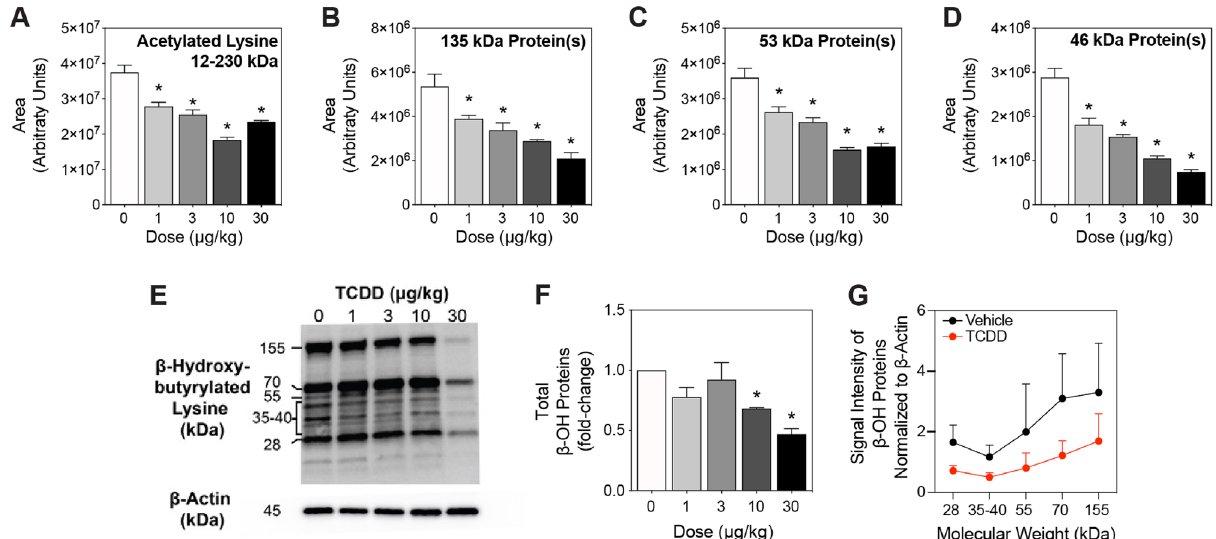
Figure 5. ( A ) Total lysine-specific acetylated proteins were assessed in livers of mice (n = 3–5) by capillary electrophoresis. Mice were orally gavaged every 4 days for 28 days with 0.01, 0.03, 0.1, 0.3, 1, 3, 10 or 30 μg/ kg TCDD prior to tissue collection. ( B–D ) Area under the three most prominent peaks for total proteins with acetylated lysine was quantified. ( E,F ) Total β-hydroxybutyrylated proteins were assessed by traditional Western blot (n = 3). Depicted is a representative Western blot of total β-hydroxybutyrylated proteins, as well as β-actin from total protein extracts. The full Western blots can be found in Supplementary Fig. 2. ( G ) The signal intensity of total β-hydroxybutyrylated proteins at various molecular weights for vehicle and 30 μg/kg treatment groups quantified using ImageJ as outlined in materials and methods. Bar graphs denote the mean ± SEM. Significance (*p ≤ 0.05) was determined using a one-way ANOVA followed by Dunnett’s post-hoc analysis. Plots were created using GraphPad Prism (v8.4.3).